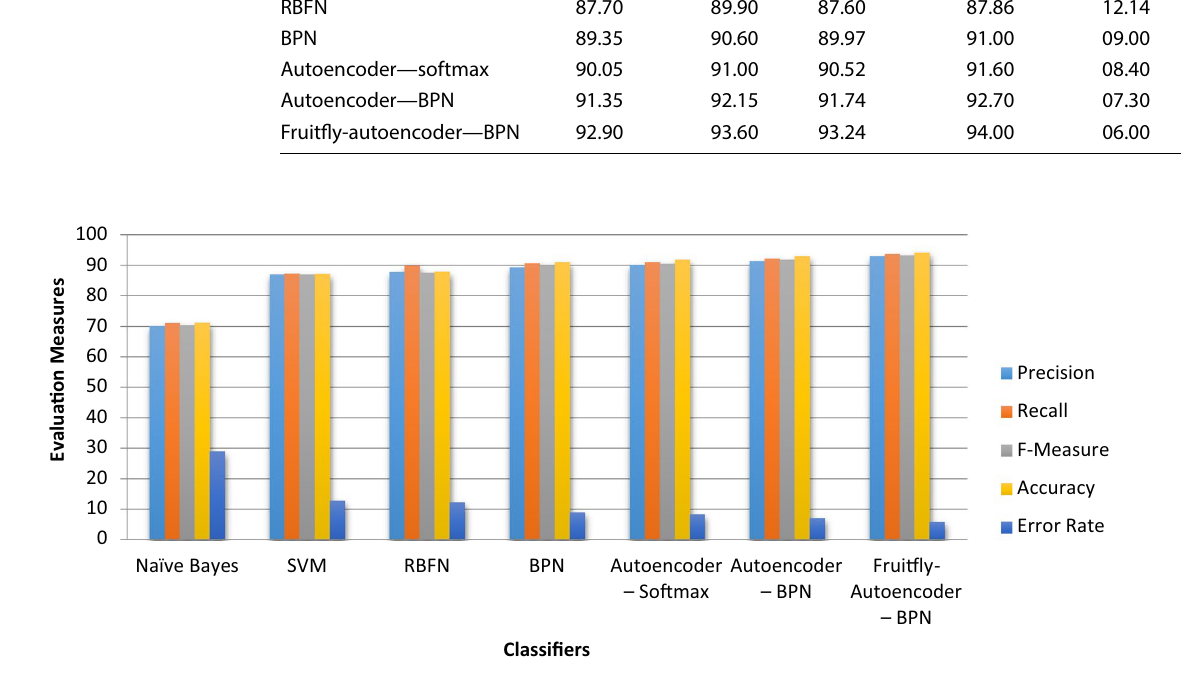
Table 10 Comparative analysis of proposed intrusion detection system with existing benchmark classifiers on NSL_